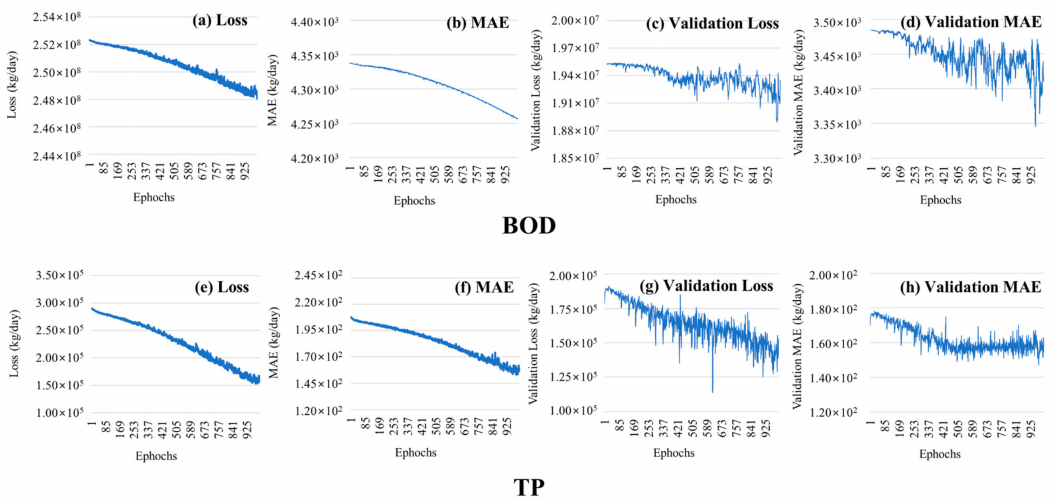
Figure 9. Result of model training for the CNN model: ( a – d ) result of BOD load model; ( e – h ) result of TP load